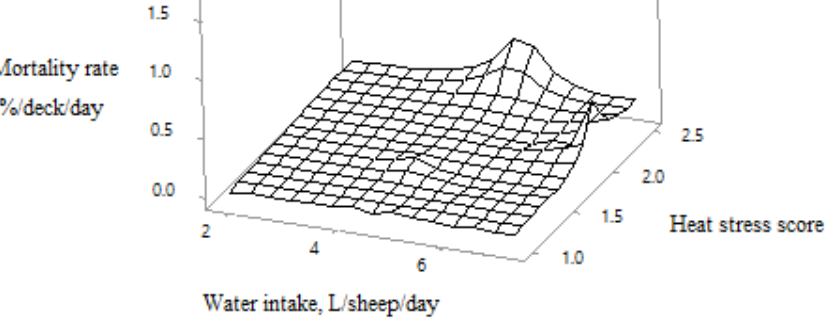
Figure 12. Relationships between water consumption, mortality and heat stress score (1 = normal, 2 = moderate and 3 = severe).